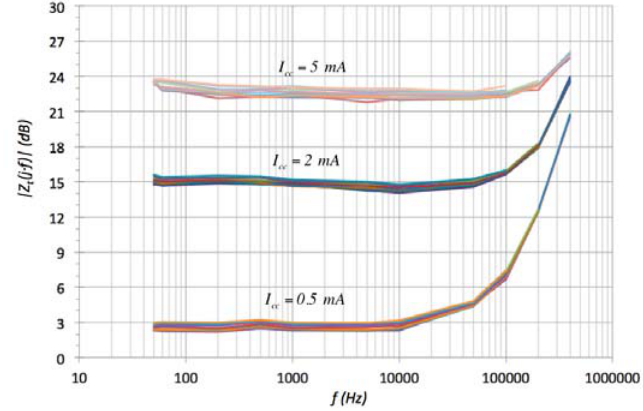
Figure 15. Dynamic behavior dependence with I magnet